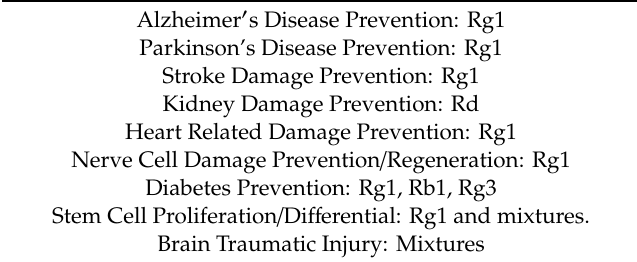
Table 3. Ginseng-induced hormetic dose response disease and endpoint.